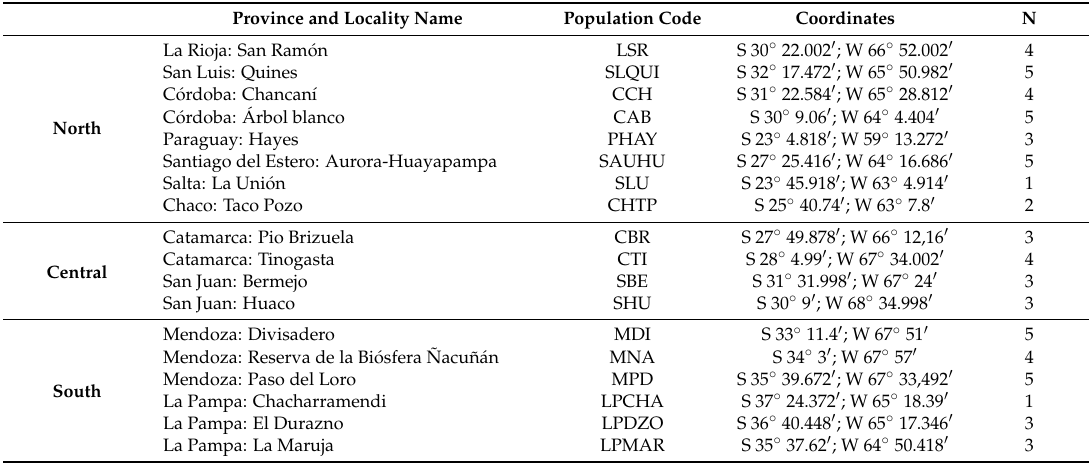
Table 1. Locality information for all sampled specimens of Hydnorobius hydnorae organized by geographic area and by locality groupings from the SAMOVA K = 3 analysis. Population codes reflect province and locality name as in Figure 2. N indicates sample size per